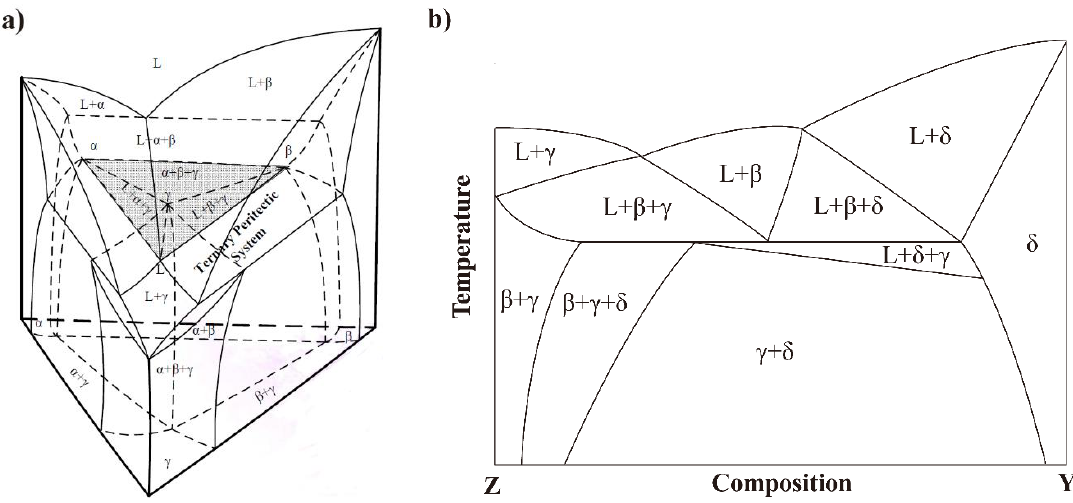
Figure 3. ( a ) Temperature–composition space diagram of a ternary system ( b ) Isopleth through a ternary system [16].